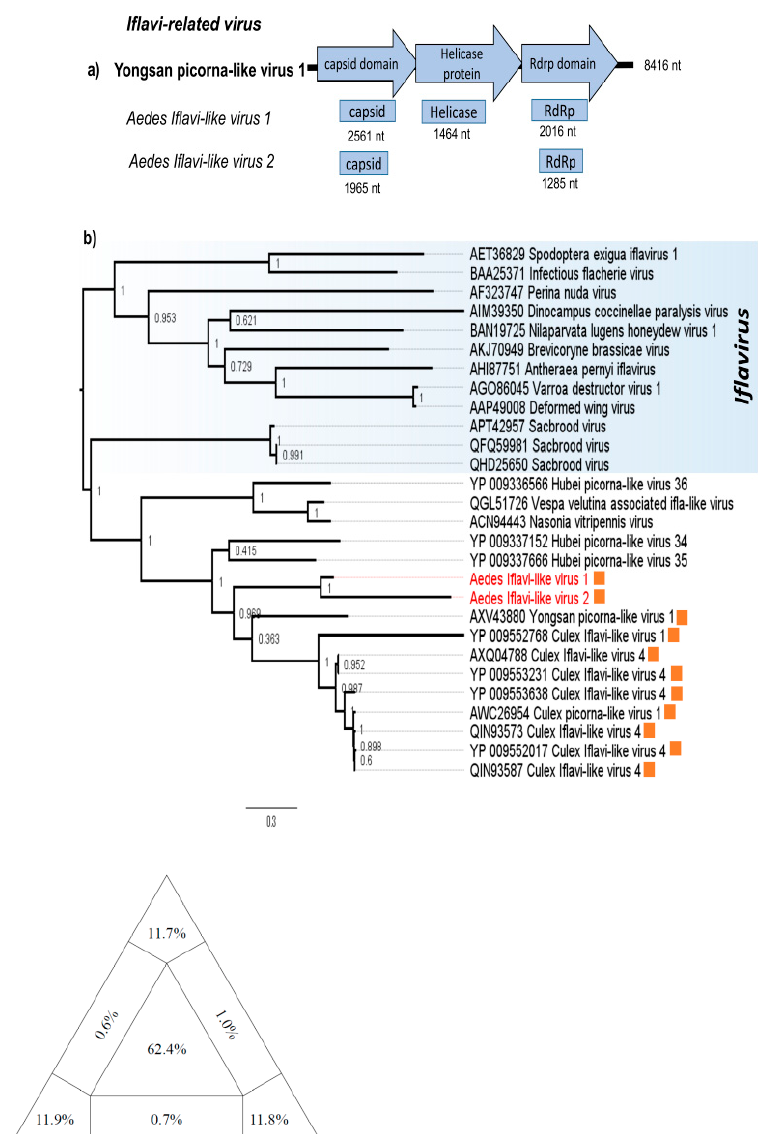
Figure 2. Iflavi-related contigs position in Yongsan picorna-like virus genome. ( a ) Contigs position of Aedes Iflavi-like virus and structure-based alignment with relative closest virus, Yongsan picorna-like virus. ( b ) Maximum likelihood tree (ML) for RdRp protein of Aedes Iflavi-like virus (orange) with Iflavirus genus (indicated in a blue area) and Iflavi-like sequences related to Aedes Iflavi-like virus by Blastp search. Sequences from the current study are colored in red. The diagram in the base of the tree is the likelihood map of the nucleotide alignment of genomes of Iflavi-related viruses. The likelihood quartet mapping is a method that allows to visualize the tree-likeness of all quartets in a single graph and provide a direct measure of the phylogenetic signal in an alignment. The triangle shows the location of all quartets calculated with the alignment used to infer the ML tree. Values in the center of the triangle represent the percentage of unresolved quartet trees (star-like trees), values in the vertices represent the percentage of fully resolved trees and values in the intermediate areas (between vertices) are the percentage of conflicting trees. The analysis was performed using JTT model as is implemented in the tree puzzle software v 5.3 (http: //